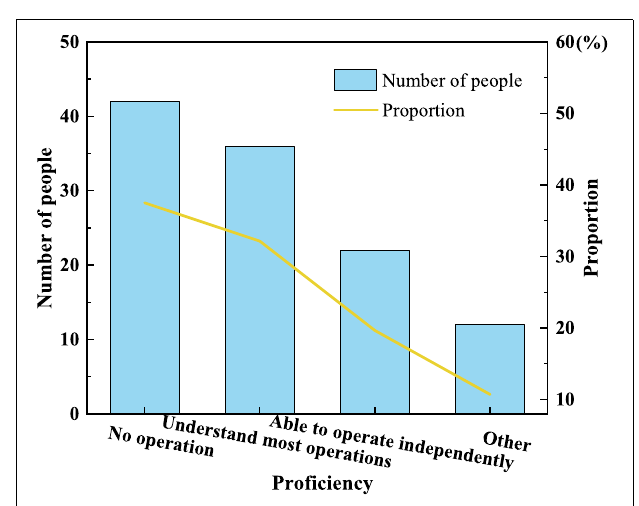
FIGURE 8 | Preschool children’s proficiency in operating mobile devices